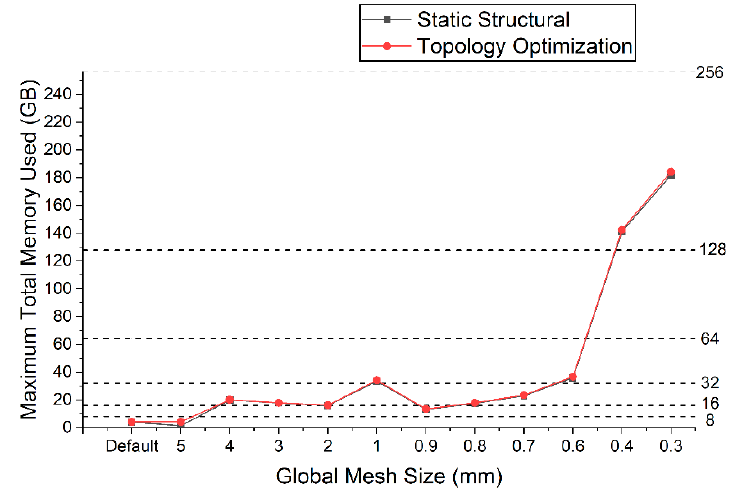
Figure 21. Memory occupation under different mesh densities.